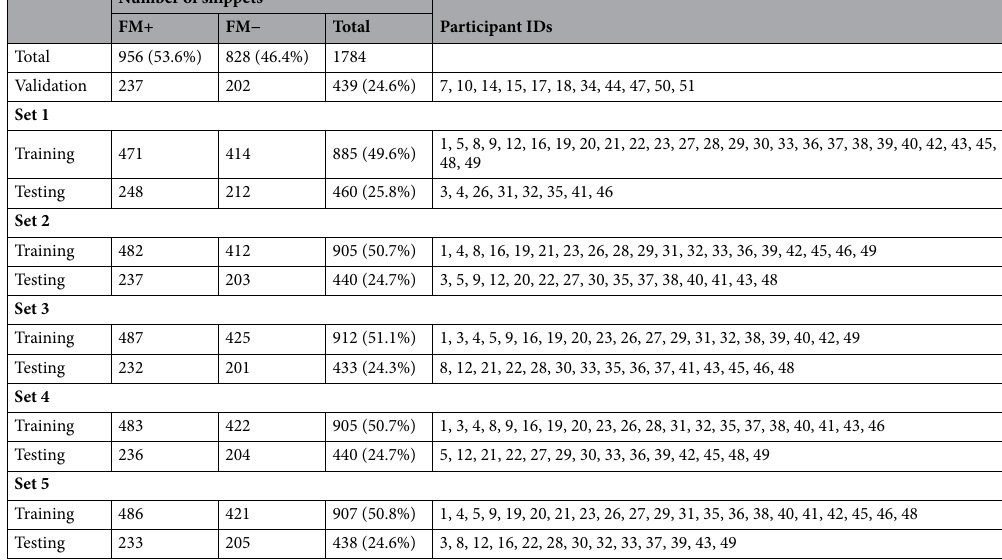
Table 2. Description of dataset splitting. The validation set was used for hyperparameter tuning whereas sets 1–5 were used for cross-validation and evaluation of network architectures.